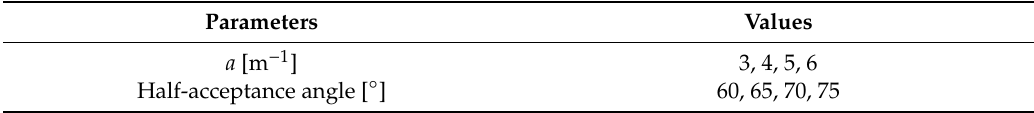
Table 5. Parametric sweep